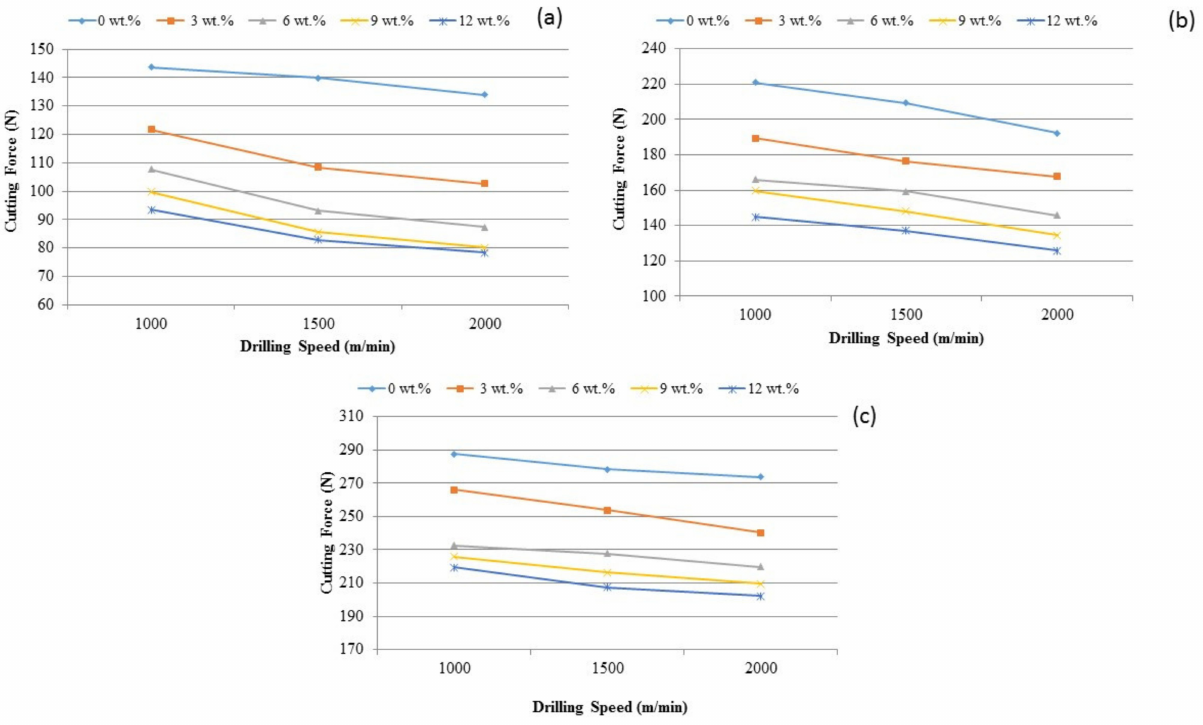
Figure 6. The influence of TiB 2 on cutting force under various drilling spindle speed and feed rate levels such as ( a ) 0.5 mm/rev, ( b ) 1.0 mm/rev and ( c ) 1.5